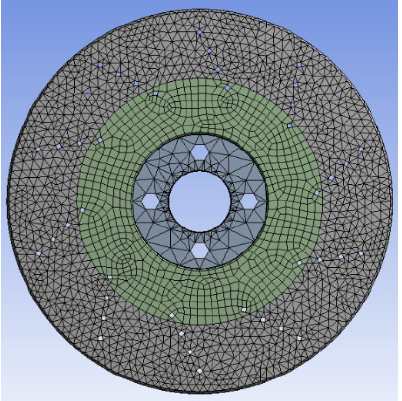
Figure 4. Mesh model.